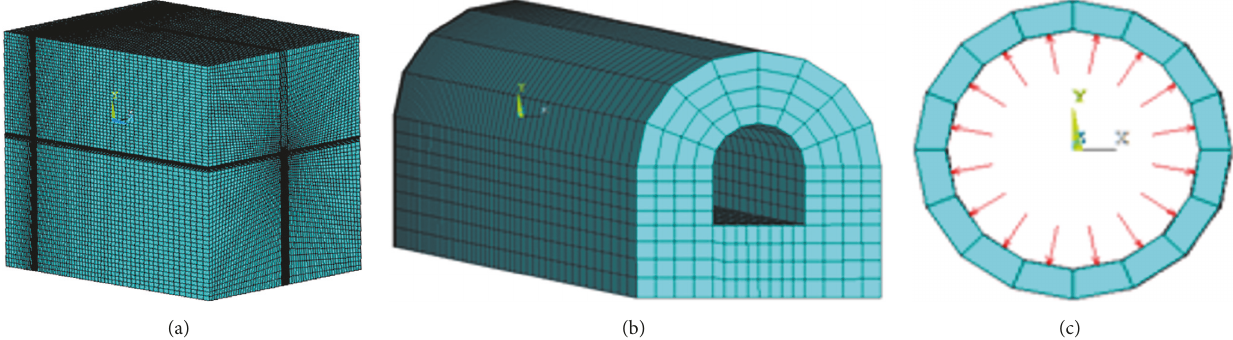
Figure 3: Numerical inversion model: (a) numerical model, (b) weakened rock masses in numerical model, and (c) applied equivalent load on wall of borehole.